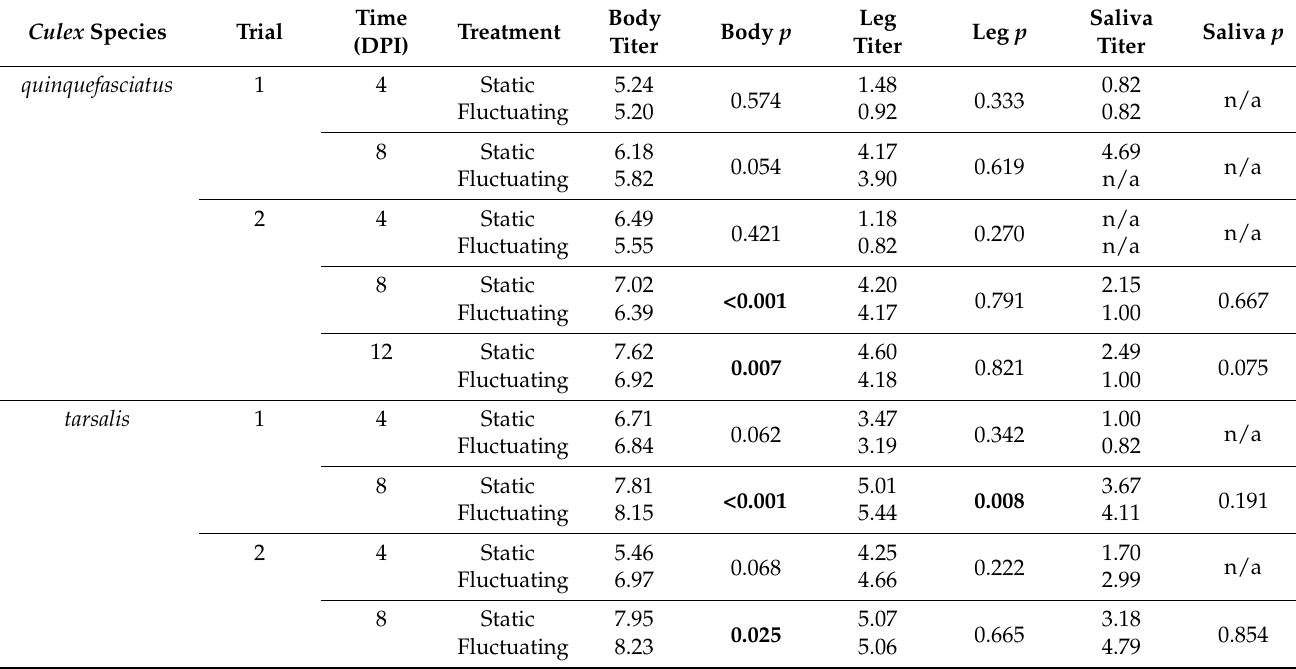
Table 2. Average viral titer present in bodies, legs, and saliva of Culex quinquefasciatus and Culex tarsalis in trial 1 (11 ◦ C DTR) and trial 2 (15 ◦ C DTR). All viral titers are expressed in log 10 PFU/mL. Time Culex Species Trial